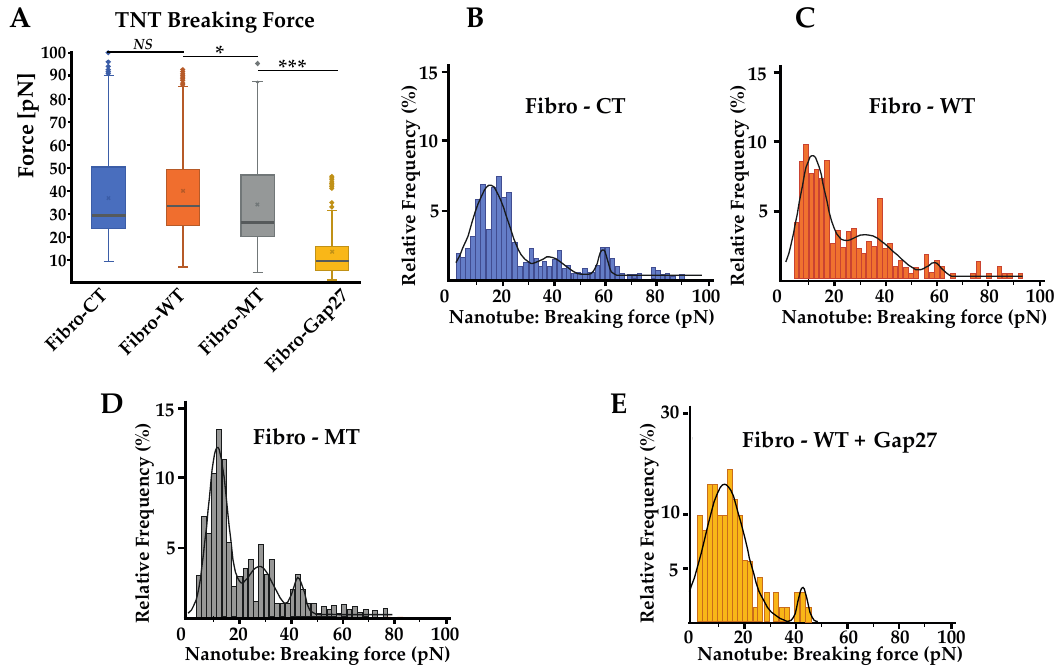
Figure 6. Nanotube pattern obtain using the AFM. ( A ) Comparison of nanotube pattern between NRVF control and wild type, NRVFs with LMNA D192G mutation and NRVFs WT incubate with Gap 27. Nanotube breaking force represents the force applied to break the link between both cells during the “long distance (5 to 80 µm) de-adhesion steps”. (n Fibro-CT = 152, n Fibro-WT = 221, n Fibro-MT = 177, n Fibro-WT + Gap27 = 122 analyzed curves, respectively). ( B – E ) Breaking force distribution histogram of nanotube pattern in different NRVF conditions. The black curves represent the overall Gaussian fit distributions. (*** p < 0.0001; * p < 0.05, NS = non-significant).